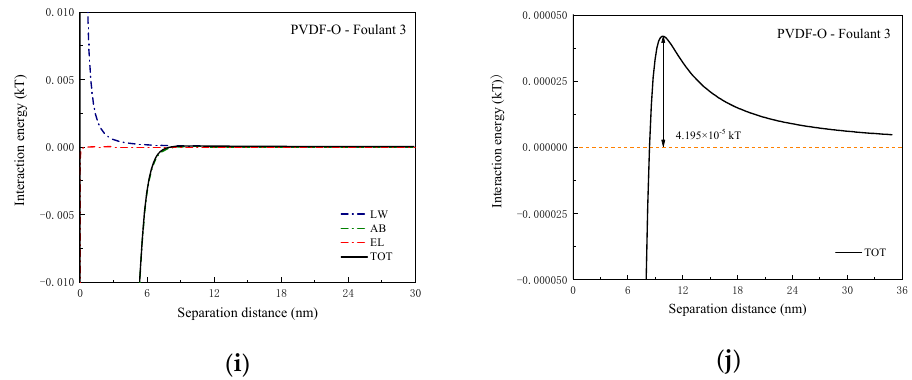
Figure 14. The variation of interfacial interaction energies between pollutants and membrane surface with different spacing: ( a , b ) PVDF-H—Foulant 1; ( c , d ) PVDF-H—Foulant 2; ( e , f ) PVDF-H—Foulant 3; ( g , h ) PVDF-O—Foulant 2; ( i , j ) PVDF-O—Foulant 3. In the process of pollutants approaching the membrane surface, there is a repulsive energy barrier. Pollutants can be adsorbed and deposited on the membrane surface only by overcoming this repulsive barrier. The repulsion barriers of the PVDF-H membrane are 1.038 × 10 − 4 kT, 1.031 × 10 − 4 kT and 1.267 × 10 − 5 kT respectively. The repulsive barrier between Ca 2+ -Mg 2+ /SDS and the membrane is the smallest, so it is easier for Ca 2+ -Mg 2+ /SDS to be adsorbed on the membrane surface, resulting in membrane fouling and wetting. The repulsion barriers of the PVDF-O membrane are 3.593 × 10 − 4 kT and 4.195 × 10 − 5 kT respec- tively. The repulsion barrier between pollutants and the PVDF-O membrane is higher than it is for the PVDF-H membrane, so it is difficult for pollutants to be adsorbed on the omniphobic membrane. According to XDLVO, the conclusion is consistent with the changing trend of flux in the process of DCMD, which means it is convincing to be utilized to analyze membrane fouling and wetting.